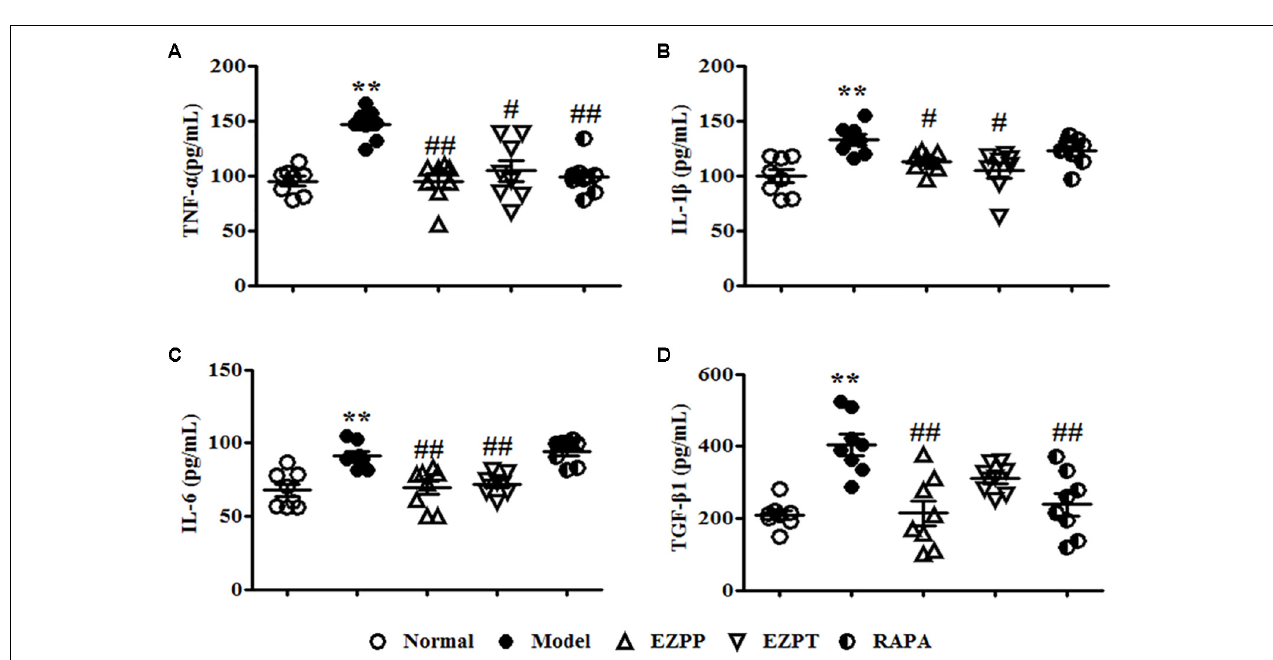
FIGURE 3 | ELISA analysis of related pro-inflammatory cytokines and TGF- β 1 in serum. Pro-inflammatory cytokines and TGF- β 1 play important roles in the inflammatory reaction and hepatic fibrosis to induce liver diseases. TNF- α (A) , IL-1 β (B) , IL-6 (C) , and TGF- β 1 (D) . Data are expressed as mean ± SEM ( n = 8). ∗ p < 0.05 and ∗∗ p < 0.01 versus Normal group; # p < 0.05 and ## p < 0.01 versus Model group.